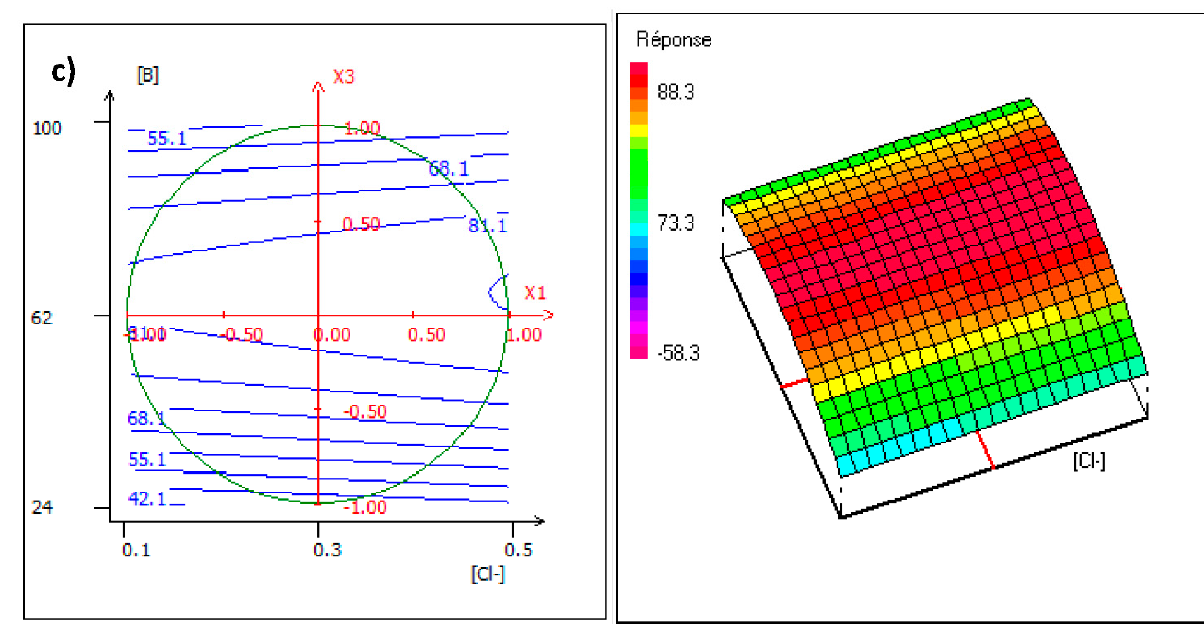
Figure 6. Contour plots and three-dimensional plots of ( a ) chloride concentration versus pH, ( b ) of boron concentration versus pH, ( c ) chloride concentration versus boron concentration.